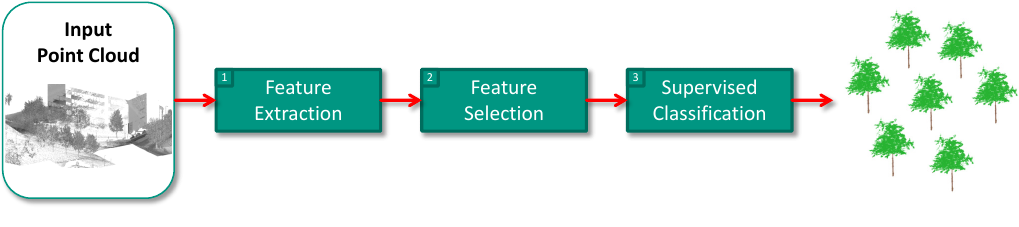
Figure 2. Illustration of the first step of our framework given by a semantic classification of “tree points” and “other points” in dense 3D point cloud data acquired in urban